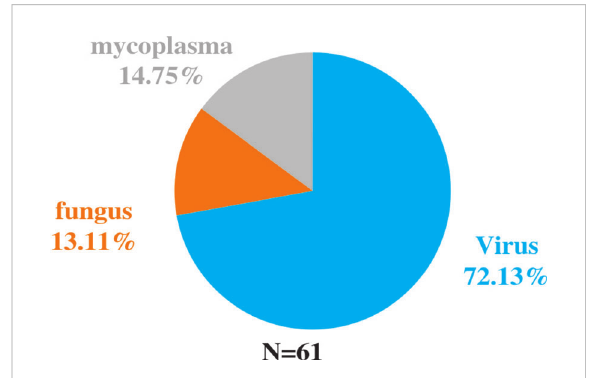
FIGURE 5 Extra pathogens detected by NGS compared to conventional detection methods after propensity